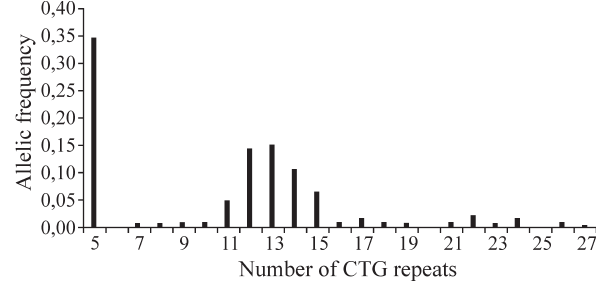
Figure 1 - Distribution of allelic frequency at DMPK locus in a sample (n = 156) of the healthy Rio de Janeiro